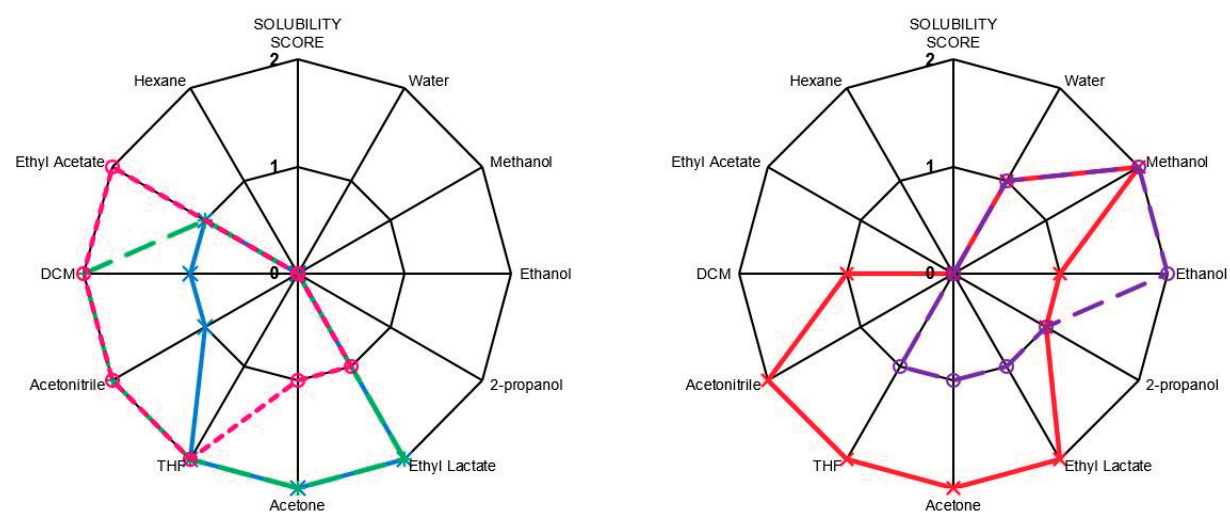
Figure 7. Solubility plots for UPEs; blue = PPI, green = PBI, pink = PBIBS, red = PGI and purple = PPISI; 0 = no solubility, 1 = moderate solubility and 2 = high